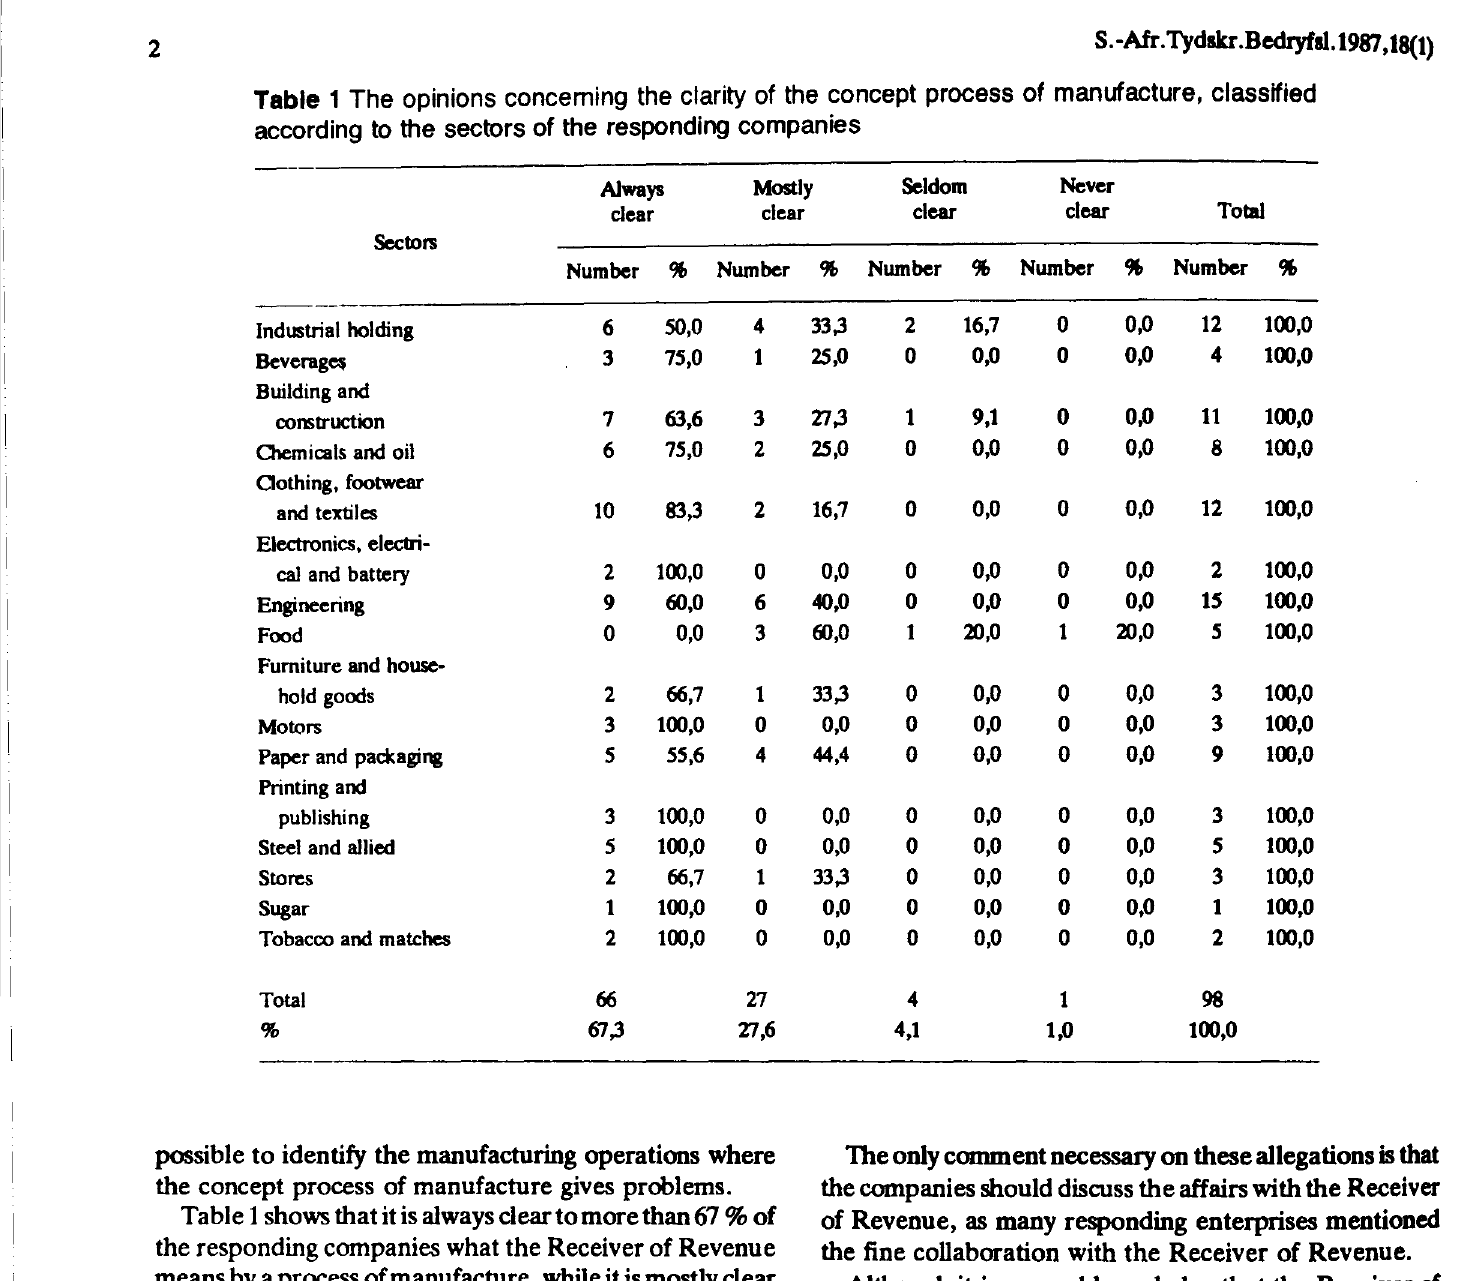
Table 1 The opinions concerning the clarity of the concept process of manufacture, classified according to the sectors of the responding